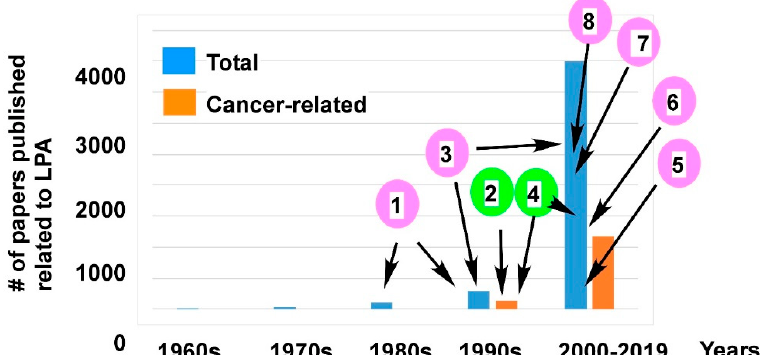
Figure 1. Lysophosphatidic acid (LPA)-related papers published in decades and the milestones in LPA research. The blue bars are the total number of LPA-related papers published in each decade. The orange bars are the numbers of LPA studies related to cancer. The pink circled numbers are milestones related to LPA research in general, and the green circled numbers are cancer-related milestones. (1) LPA’s mitogen and growth factor like activity, as well as G-protein-mediated signaling mechanisms were discovered in the late 1980s and early 1990s [35,53–59]. (2) In 1995, the pathological